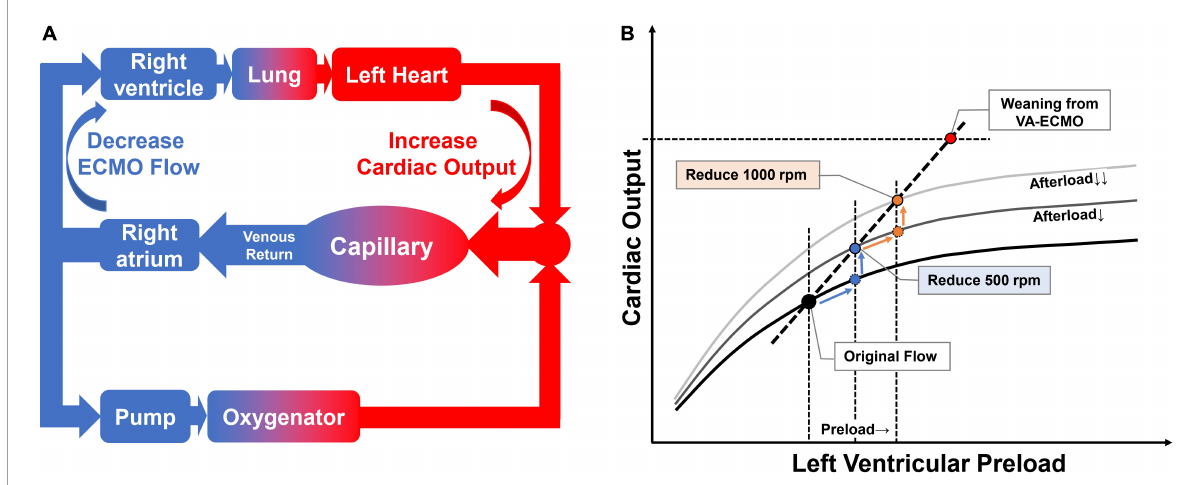
FIGURE1 Effect of flow challenge test (FCT) on blood flow re-distribution and ventricular performance. Panel (A) the effect of reduced pump rotation speed on native cardiac output. When we reduce the V-A ECMO flow, the excess blood goes to the native heart and is then ejected into the systemic circulation. Panel (B) the flow challenge test shifts the cardiac operating points to the upper right on Frank-Starling curve. By stepping down the rotation speed of the V-A ECMO pump, the operating point shifts to the right along the Frank-Starling curve. In addition, the Frank-Starling curve itself shifts upward as afterload is reduced due to a decrease in retrograde blood flow. The combined effect is a shift of the heart’s operating point to the upper right.